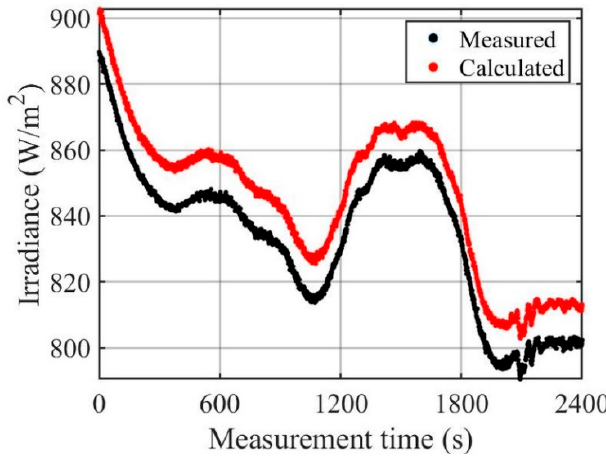
Figure 4. The operating irradiance obtained from the fits to the entire I – U curves with 100 representative points jointly with the measured irradiance during the 40 min measurement period.